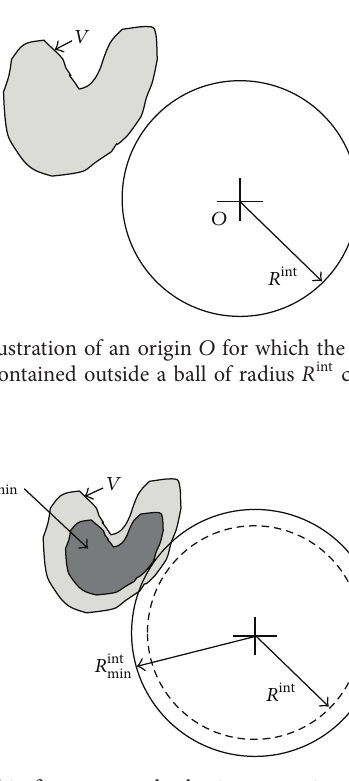
Figure 6: This figure expands the interpretation of Figure 5. It illustrates the relations between 𝑉 min and 𝑉 , and 𝑅 int min and 𝑅 int , for the same source and origin shown in Figure